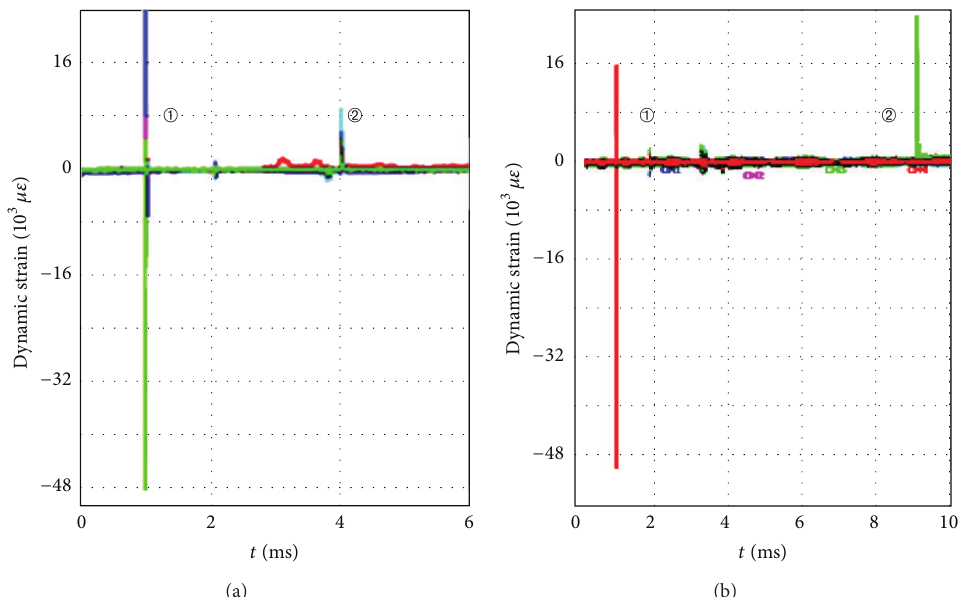
Figure 3: Measured curves of the blasting wave and the reflected wave from the free face.